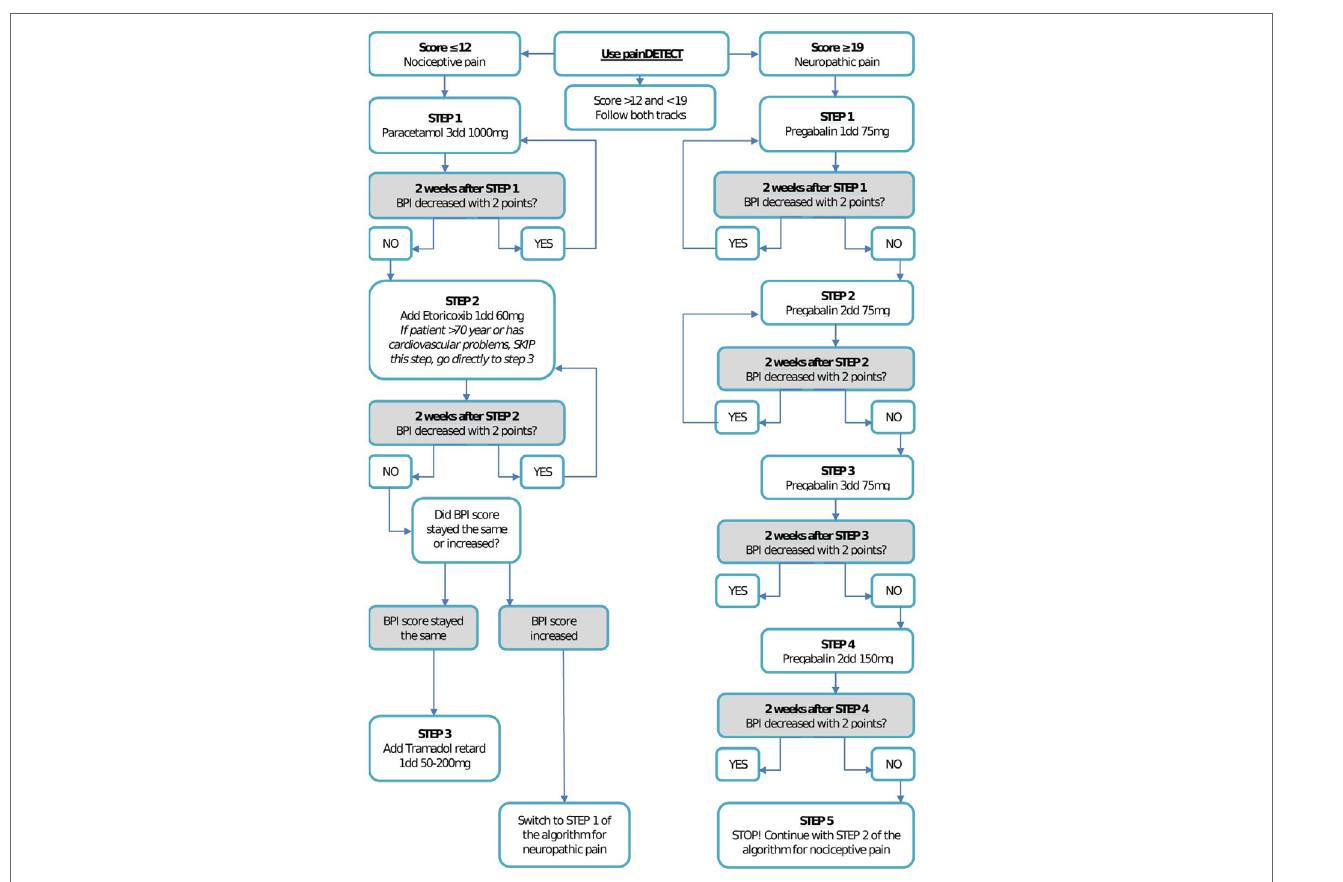
FigUrE 1 | Pain medication algorithm for nociceptive pain (left track), neuropathic pain (right track), and mixed pain (both